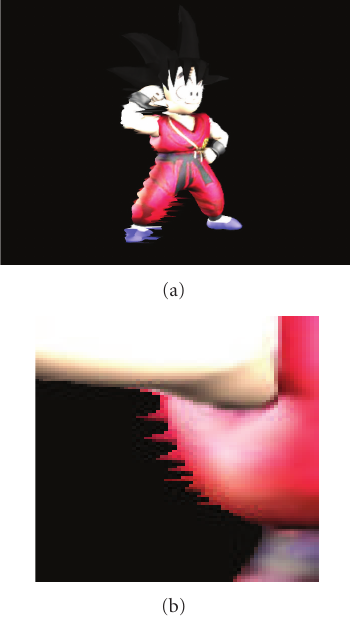
Figure 17: Example of artefacts due to depth packets